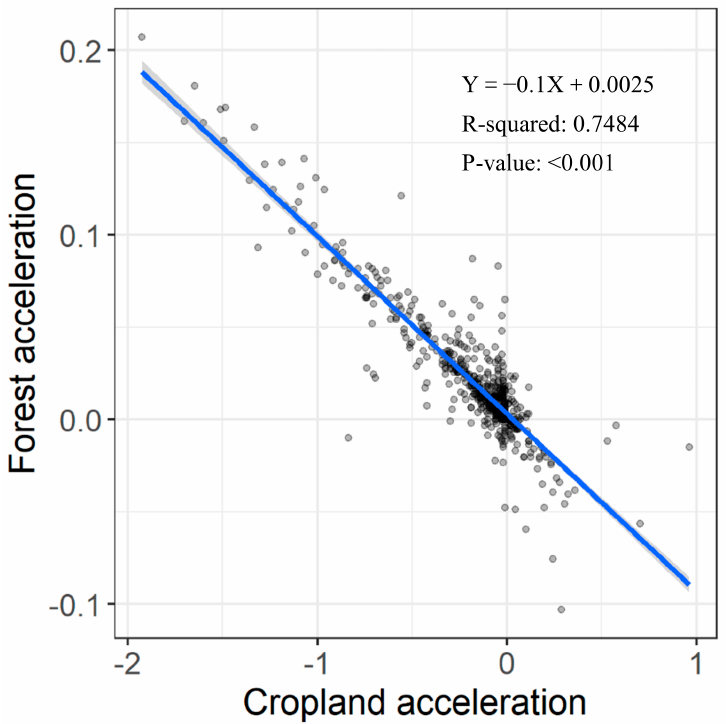
Figure 11. The linear regression result between the acceleration of cropland and forest.